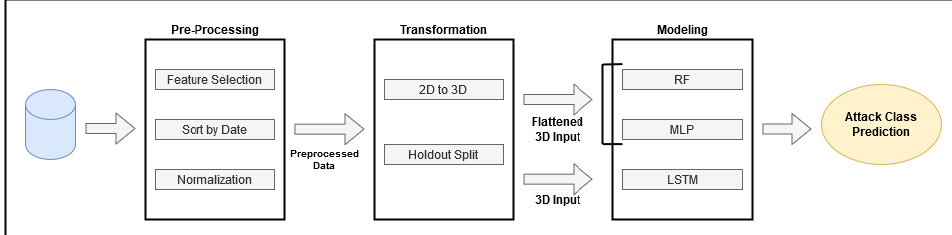
Figure 7. Anomaly Detection